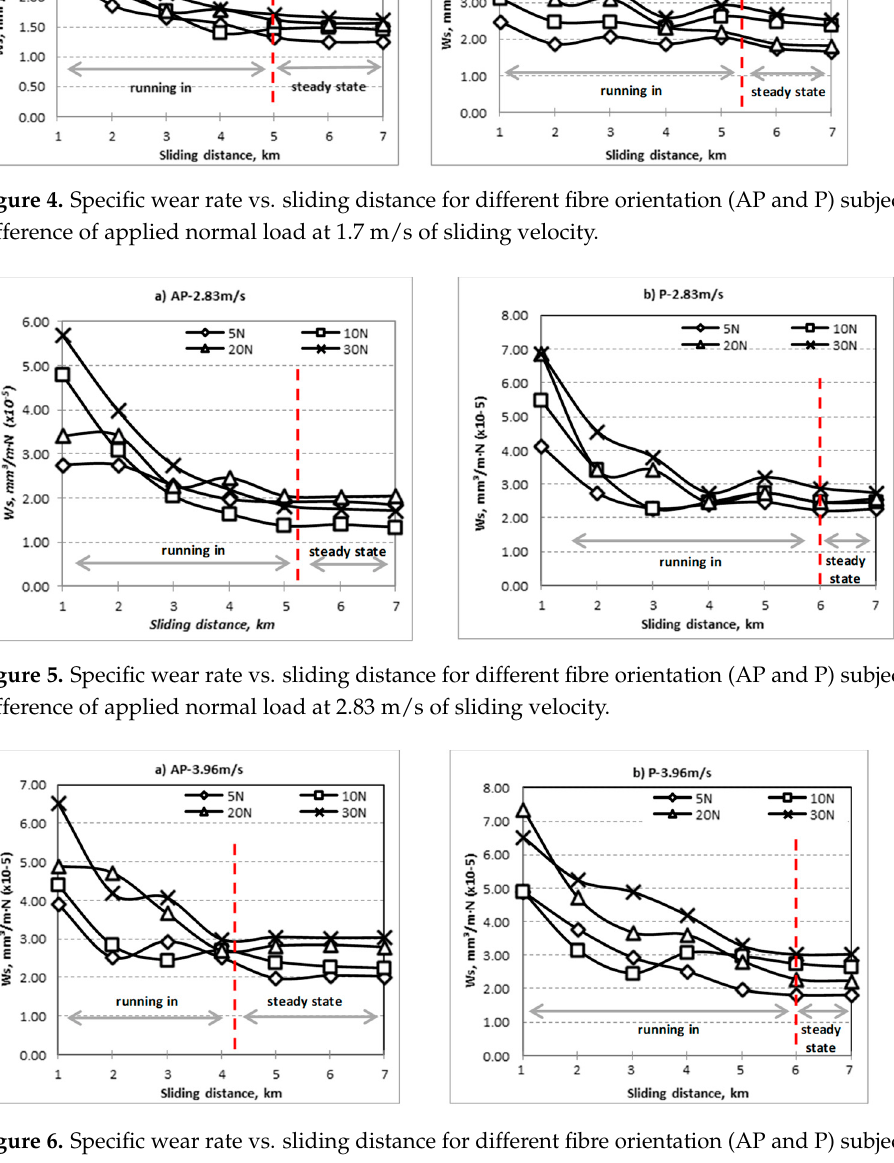
Figure 6. Specific wear rate vs. sliding distance for different fibre orientation (AP and P) subjected to difference of applied normal load at 3.96 m/s of sliding velocity .